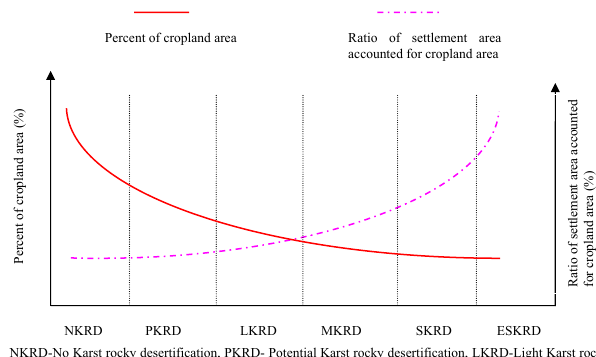
Figure 5. The theoretical formation models of KRD in the peak- cluster depression